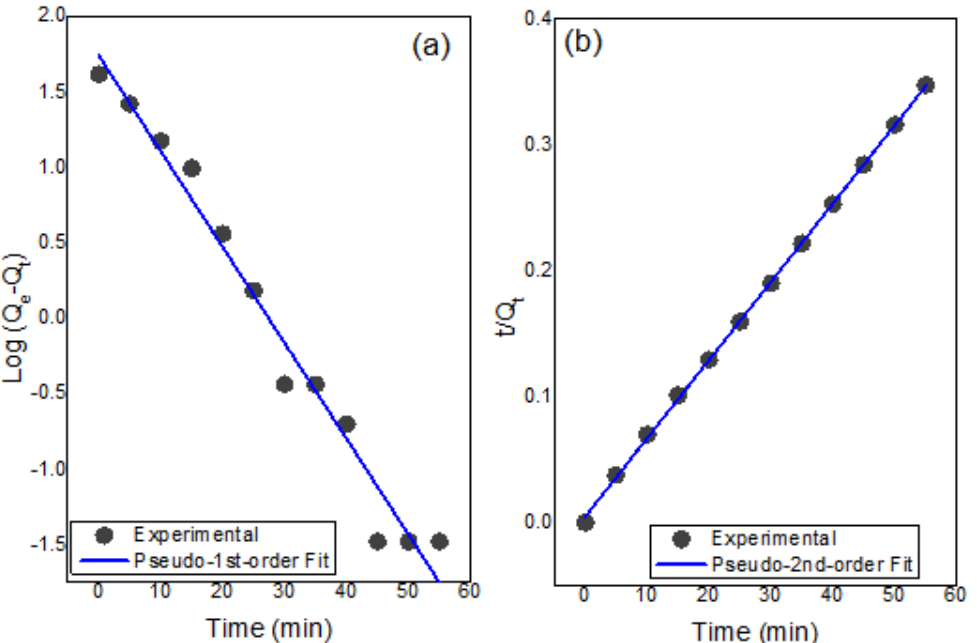
Figure 8. Plots of the ( a ) pseudo-1st-order, and ( b ) pseudo-2nd-order model for MG adsorption onto AC@PIN composite [Co = 150 mg L − 1 ; Temperature = 20 °C; AC@PIN = 6 mg, contact time = 60 min, pH = 10].